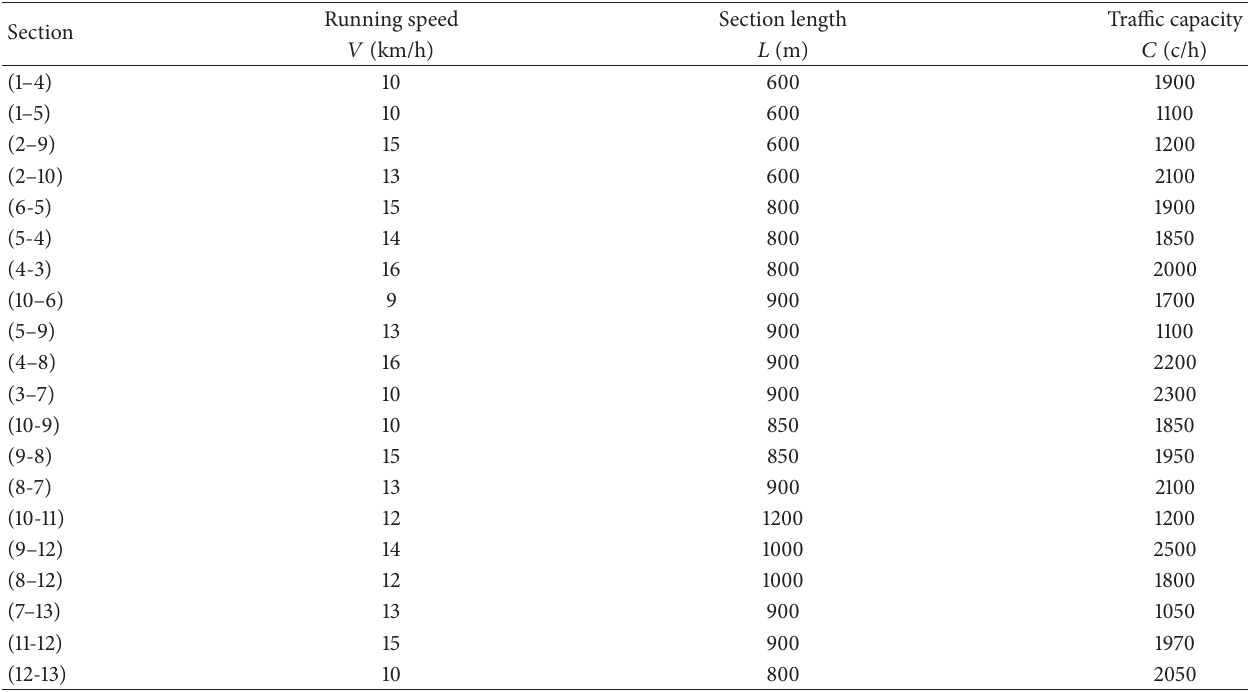
Table 1: Basic parameters setting.